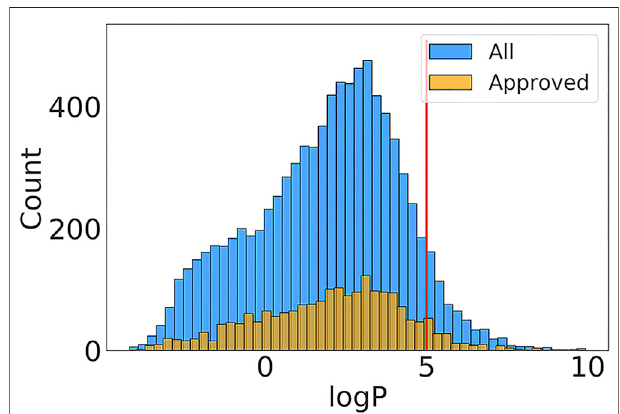
FIGURE 2 | The logP value distributions in “ Approved ” and “ All ” subset of DrugBank. The red line represents the upper value of logP in Lipinski ’ s rule of fi ve invented by P fi